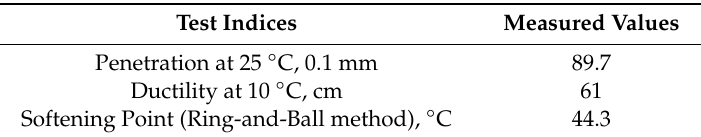
Table 1. Test results of SK-90 base asphalt.